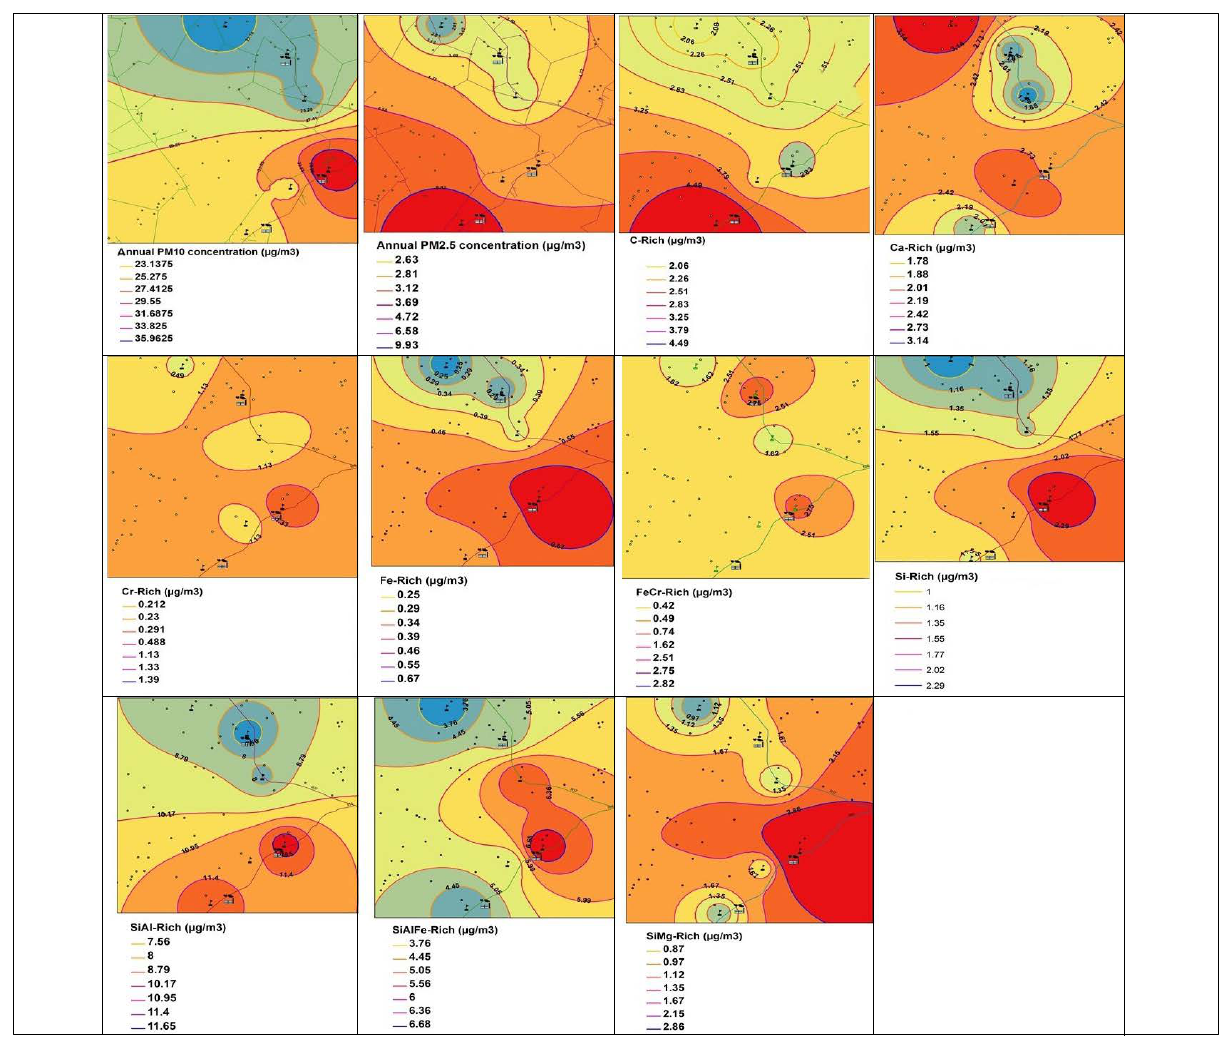
, PM , and C-rich, Ca-rich, Cr-rich, Fe-rich, FeCr-rich, Si-rich, SiAl-rich, SiAlFe-rich and SiMg-rich Figure 3: Maps of annual spatial variation for PM 10 2.5 particles. High concentrations are shown in dark red and low concentrations are depicted in blue. The highest Ca-rich concentrations were observed around Site 6, which is located in an area with black cotton soil. However, because the sites were not equally spaced in the study area, other methods such as the COD and r were used to confirm and validate the results of the spatial analysis determined using the geographic information system. The COD values were calculated (Table 2) to characterise the spatial heterogeneity of PM , PM and PM chemical components. 10 2.5 Results of coefficient of divergence (COD) analysis for